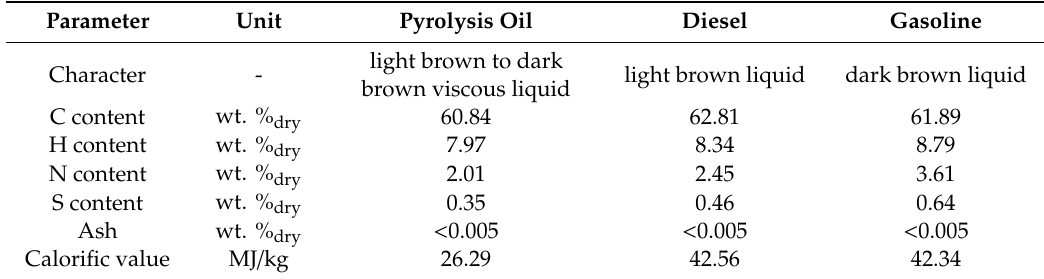
Table 3. Final products of waste plastics pyrolysis